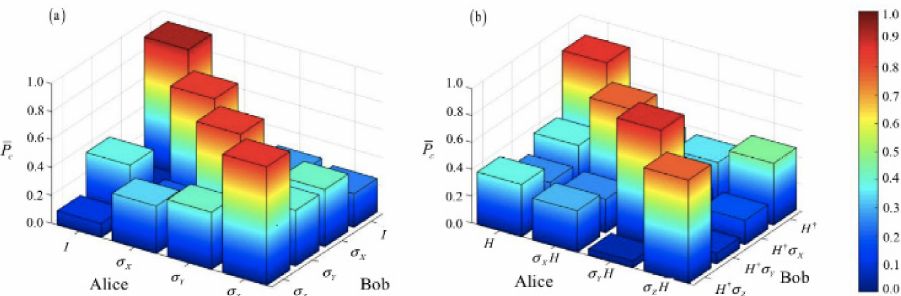
Figure 5. P c is the coincidence probability of the quantum encryption scheme with a single qubit unitary operator for quantum message authentication. P c = 1 − P c represents the probability of two quantum message states being matched. In ( a ), P c corresponds to the quantum encryption scheme with a single qubit unitary operator that Alice and Bob can select when secret key k i of Alice and Bob is zero. In ( b ), P c corresponds to every type of quantum encryption with single qubit H unitary operator that Alice and Bob can select when secret key k i of Alice and Bob is one. In this experiment, message m i H was set to 135 ◦